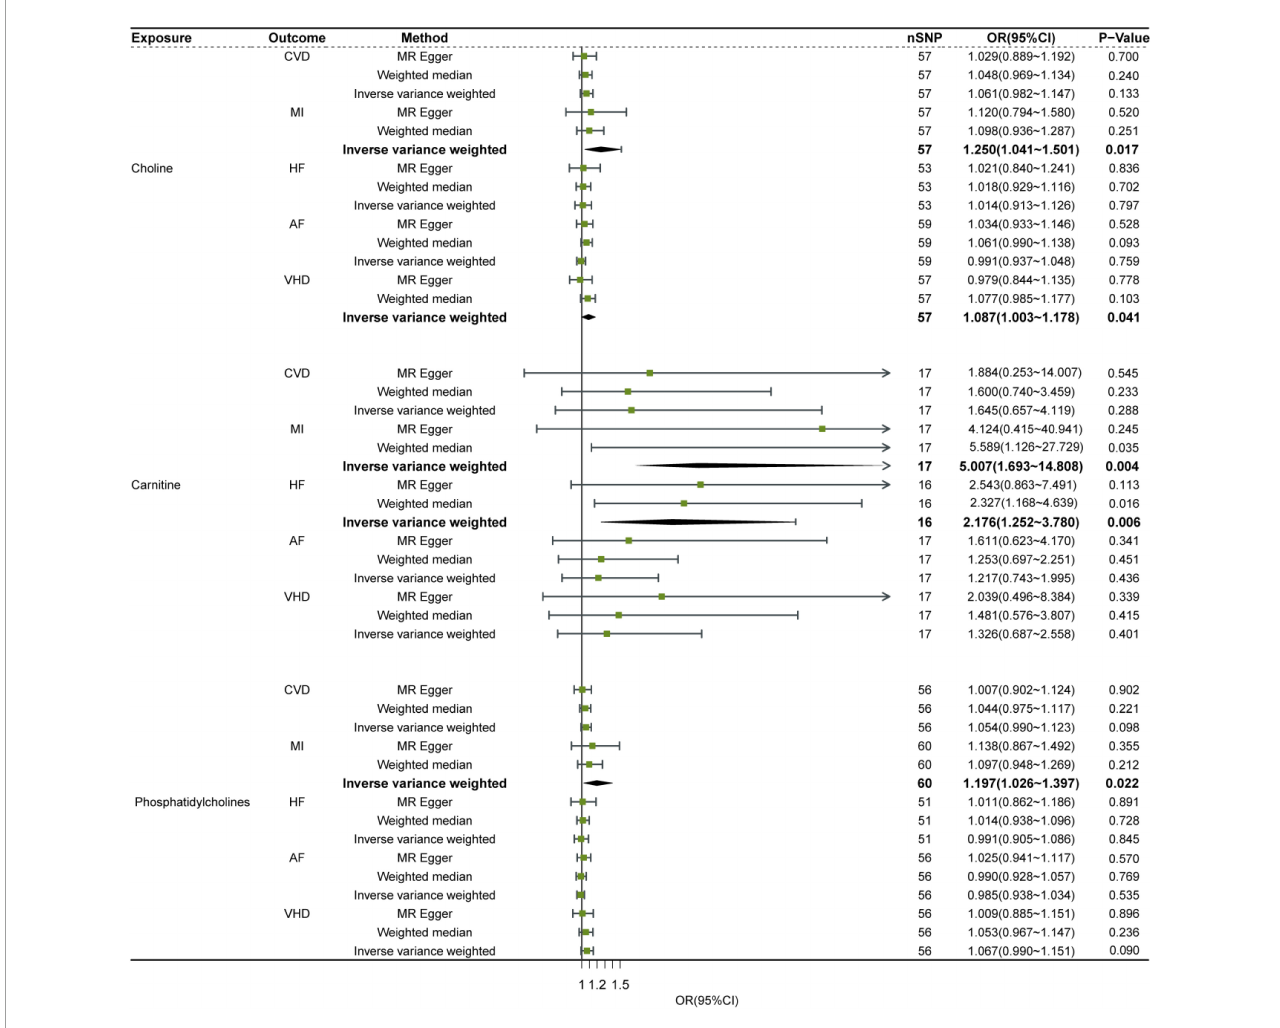
FIGURE2 Relationship of Dietary precursors with five cardiovascular diseases by SVMR analysis. Sensitivity was determined by the listed methods. OR, odds ratio; CI, confidence interval; CVD, cardiovascular disease; MI, myocardial infarction; HF, heart failure; AF, atrial fibrillation; VHD, valvular heart disease.